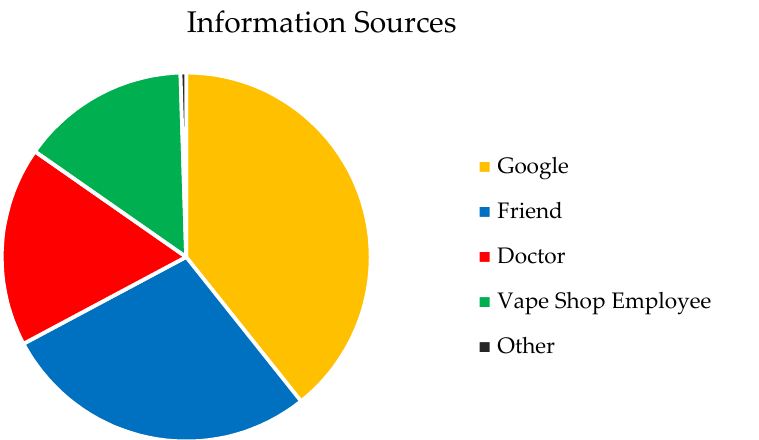
Figure 1. Percentage of participants who correctly recognized e-cigarette ingredients.